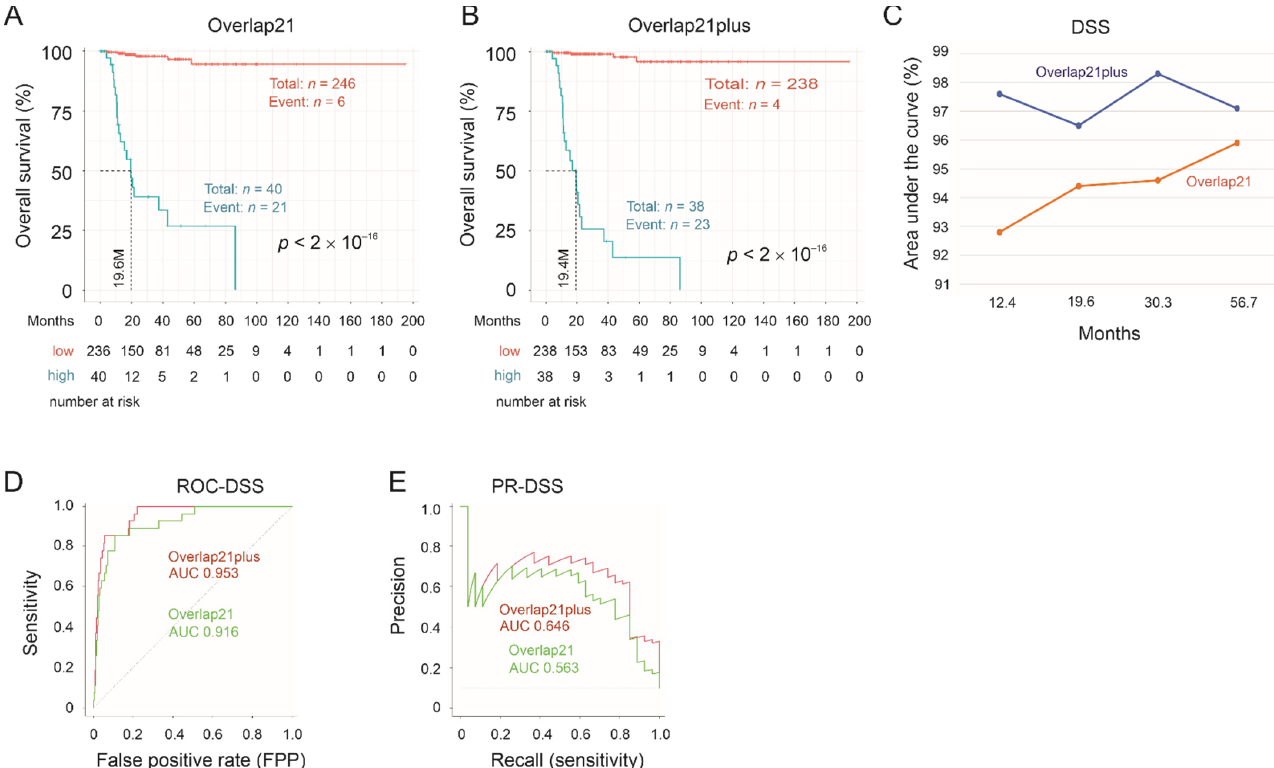
Figure 7. Stratification of the risk of disease-specific survival (DSS) by Overlap21 and Overlap21plus. ( A , B ) Separation of a high- and low-risk group based on DSS by Overlap21 and Overlap21plus risk scores. ( C ) tROC analysis. ( D , E ) ROC-AUC and PR-AUC curves for the indicated events.